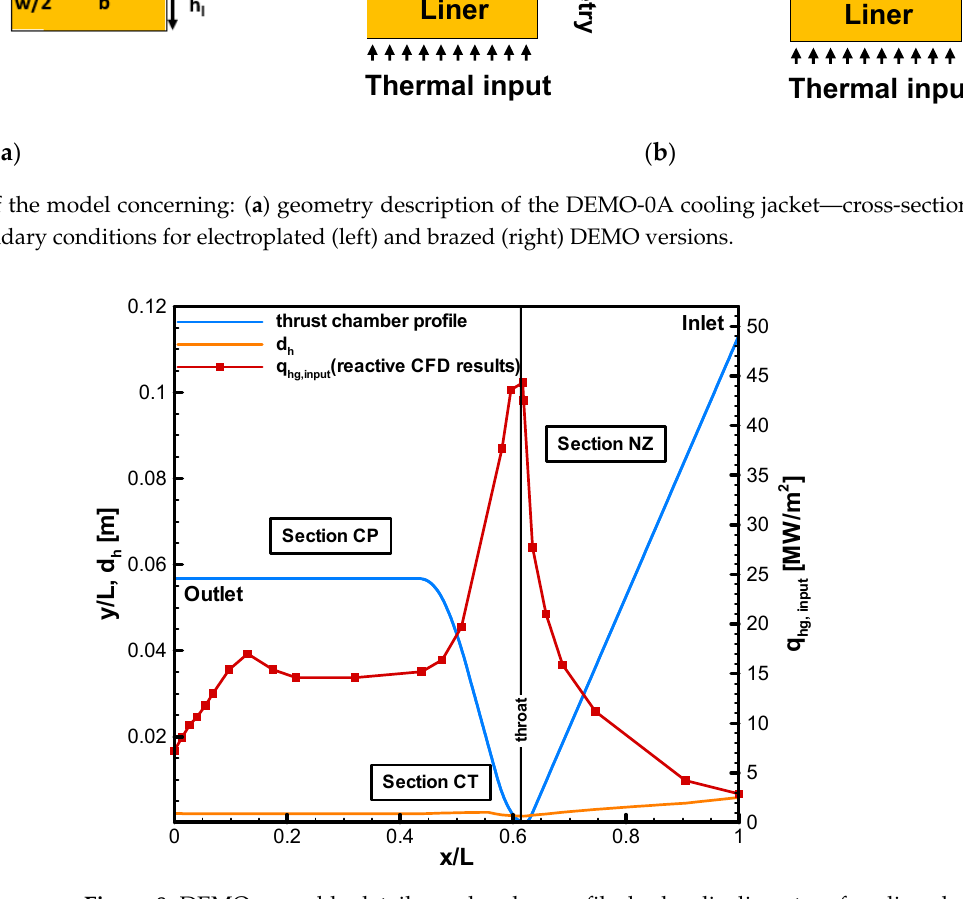
Figure 8. DEMO assembly details on chamber profile, hydraulic diameter of cooling channels and input heat flux profile.